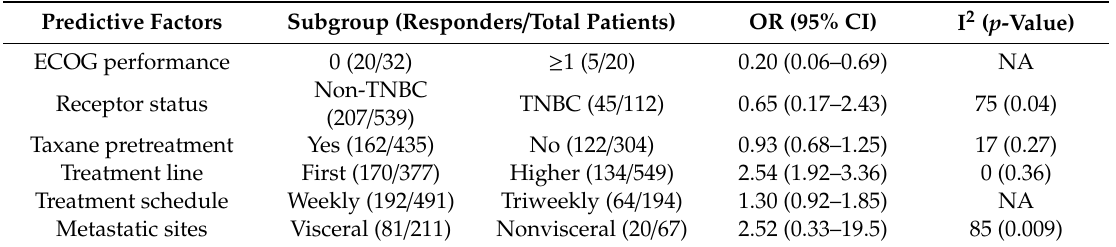
Table 2. Predictive factors for overall response rate to nab-paclitaxel.